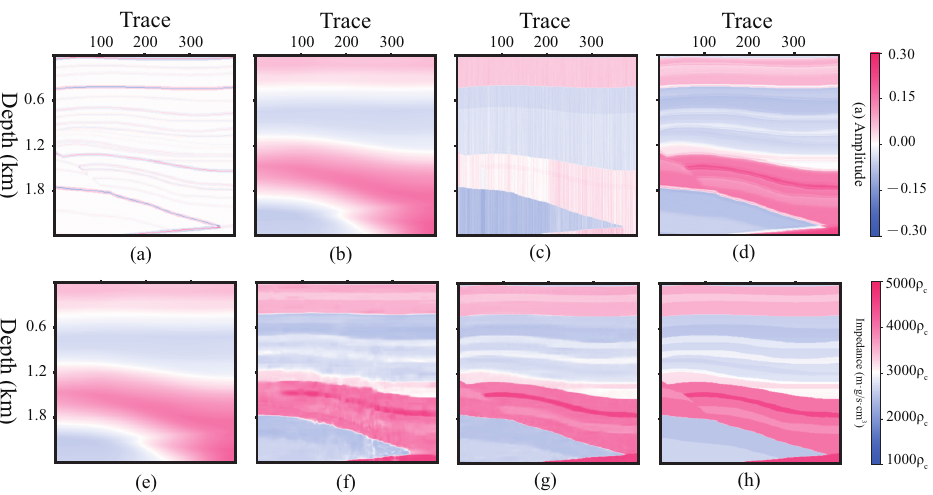
Figure 23. Profiles. ( a ) M , seismic profile, ( b ) B , background impedance profile, ( c ) predicted by deconvolution and recursive inversion, ( d ) predicted by TV regularization, ( e ) predicted by TCN, ( f ) predicted by 1D U-Net, ( g ) predicted by self-attention U-Net, ( h ) label profile Z